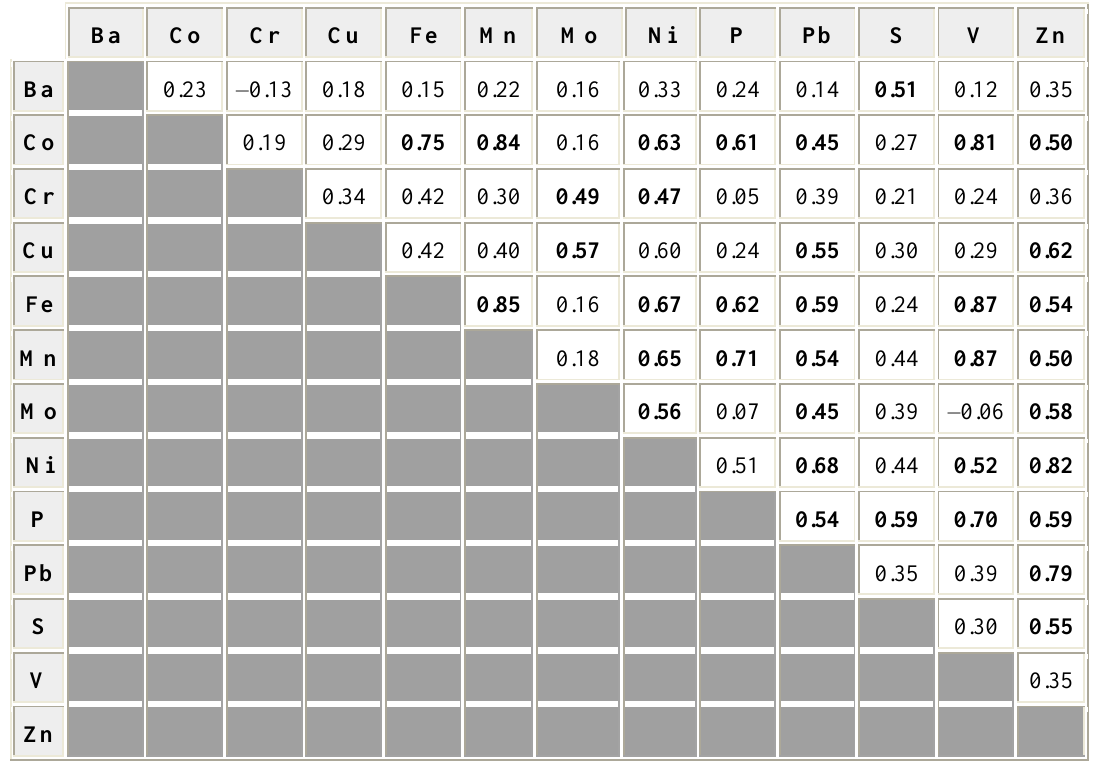
Table 3. Matrix of Spearman Rank Correlations of all available analyzed elements in road dust in residential Neighborhood Planning Unit V, Atlanta, GA,